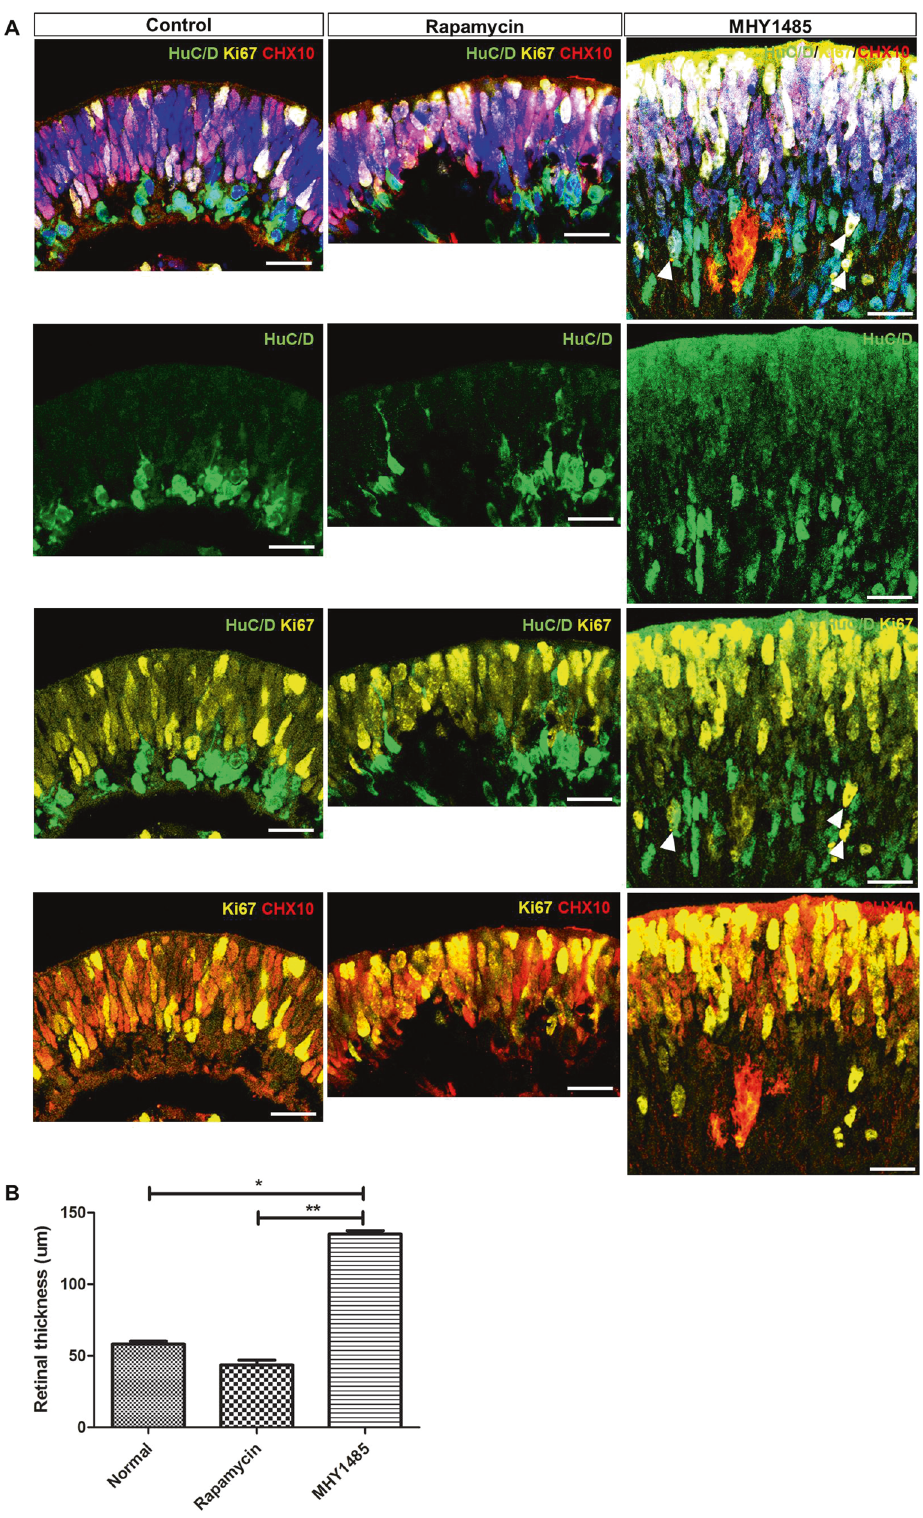
Fig. 4 Temporal characteristics of proliferation and differentiation in ROs upon modulation of mTORC1 activity. A Comparison of proliferation and differentiation in control, rapamycin-treated, and MHY1485-treated ROs shown by immunostaining of Ki67 (yellow) and CHX10 (red) at 40 days of differentiation. In control and rapamycin-treated ROs, Ki67, and CHX10 expression was found in outer layers without any co- localization with HuC/D expression, while ROs with MHY1485 treatment showed upregulated expression of Ki67 and CHX10 throughout all RO layers, including RGC and outer neuroblastic cell layers. Disrupted retinal laminar structure was evident in MHY1485-treated ROs. B The average retinal thickness of in control, rapamycin-treated, and MHY1485-treated ROs. Arrowheads indicate co-localization of HuC/D and Ki67 expression. Data are expressed by mean ± S.E.M. * p < 0.05, ** p < 0.01 by the Kruskal – Wallis test with post hoc analysis. Scale bar, 25 μ m.